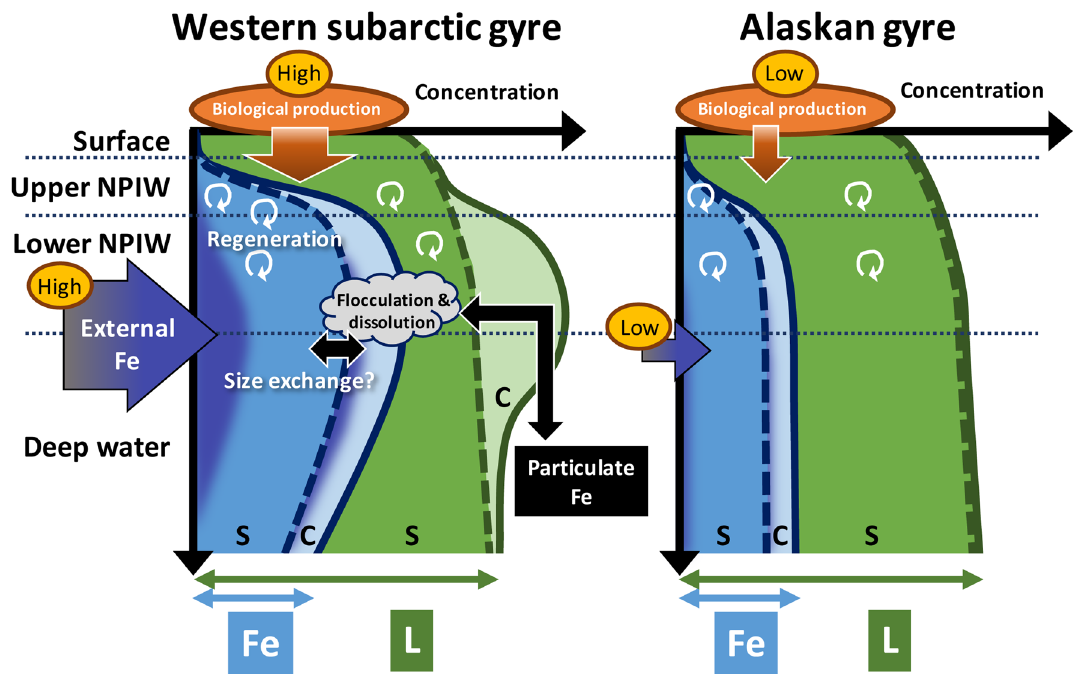
Figure 5. Schematic of the differences in the vertical distributions of size-fractionated Fe speciation between the Western subarctic gyre (WSG) and the Alaskan gyre (AG). Light blue and blue color areas indicate the Fe concentration. Light green and green color areas indicate the excess ligands concentration. Dashed lines indicate the boundary between the soluble (S) and colloidal (C) fractions. Blue purple color areas in Fe concentrations indicate the influence of external Fe. The dotted lines indicate the boundaries between water masses in this study. In the WSG, higher external Fe input (blue purple arrow) from the Okhotsk Sea (mainly upper